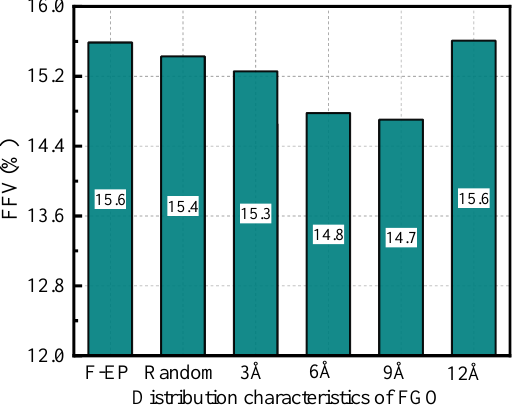
Figure 8. FFV of FGO/F-EP composites with different distribution characteristics.